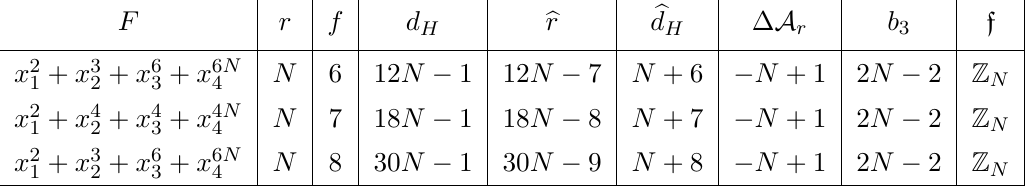
Table 3 . Isolated hypersurface singularities engineering the rank- N E n theories, for n = 6 , 7 , 8